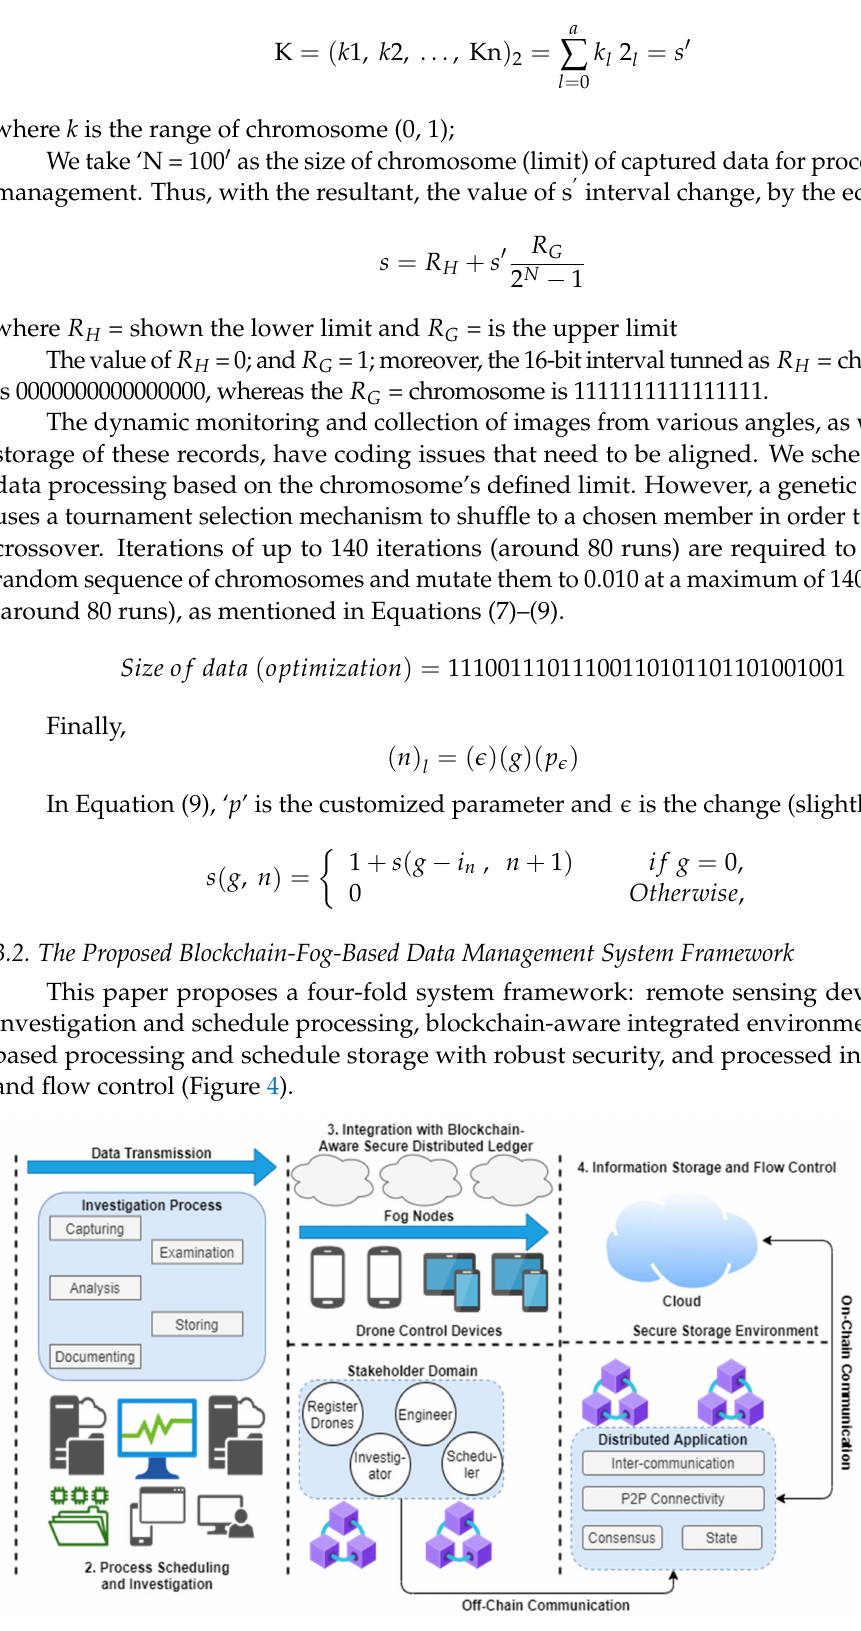
Figure 4. The Proposed Blockchain-Aware Distributed Dynamic Monitoring and Fog-based Data Processing and Manage- ment